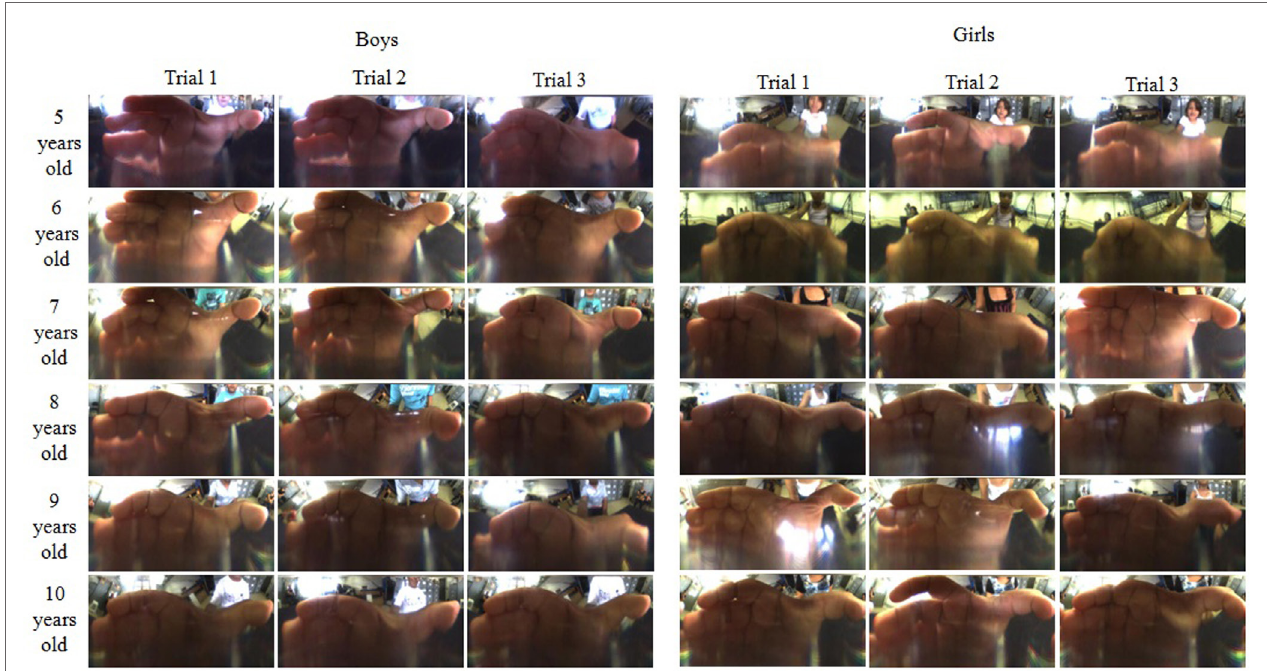
FIgURe 8 | hand posture images organized by gender, boys on the left and girls on the right, by trial, 3 for each child, and by age, from 5 up to 10 years old in each line